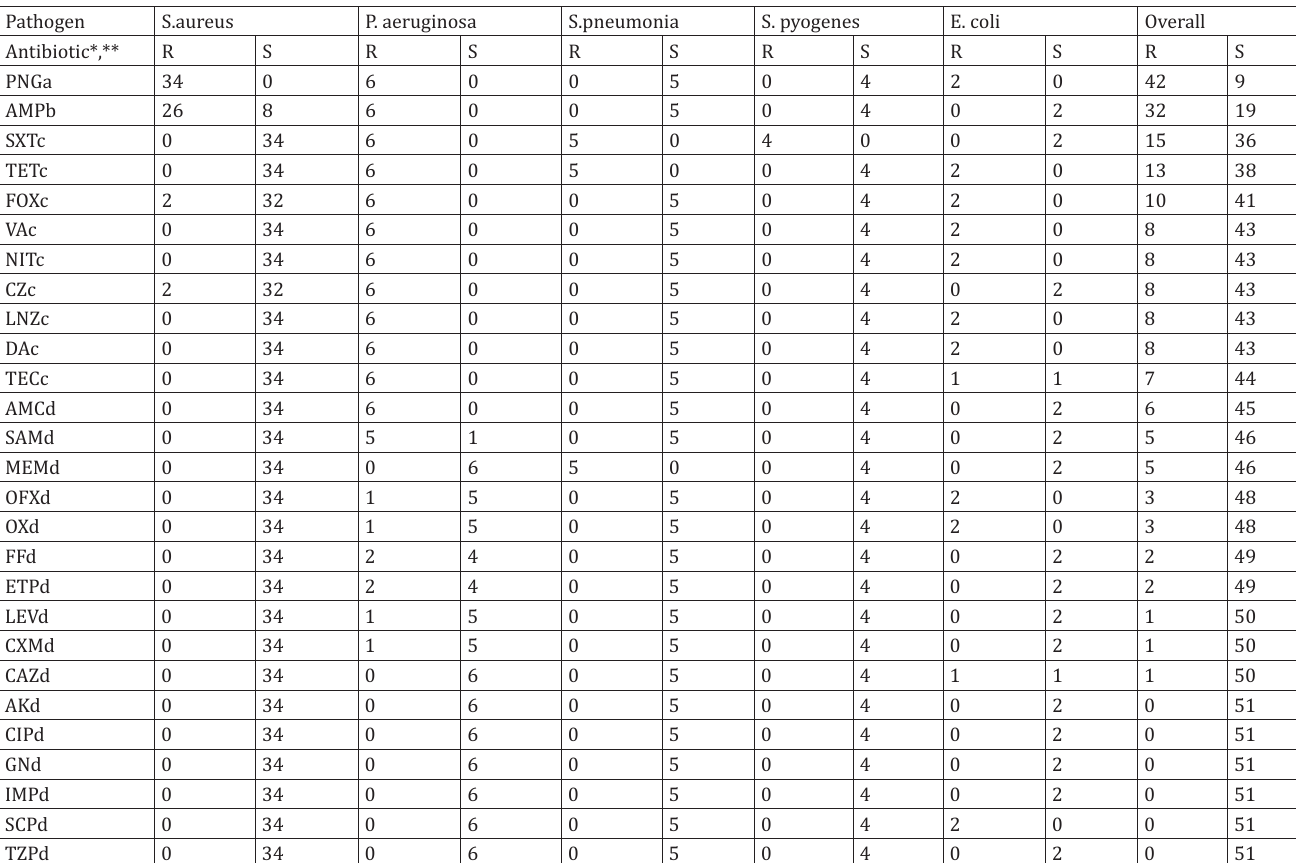
Antibiotic-susceptibility results for all potential pathogenic